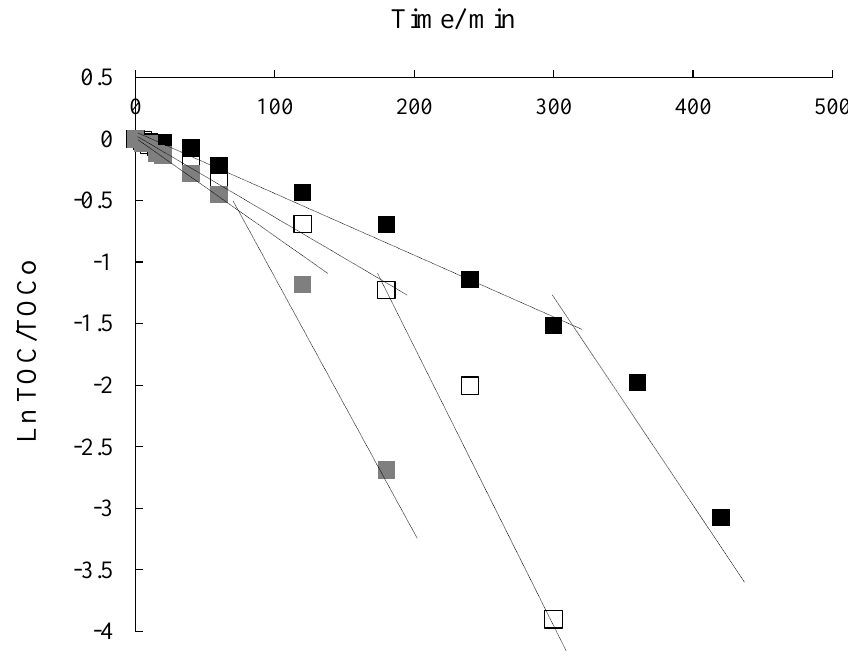
Figure 2. TOC removal in semi-log scale during electrolysis of AMX and AMP solutions carried out in sulphate media (3 g L − 1 of Na 2 SO 4 ) at three current densities: 15 ( (cid:4) ), 30 ( (cid:3) ) and 60 ( (cid:4) ) mA cm − 2 . Initial concentration was 100 mg L − 1 of AMX and 100 mg L − 1 of AMP.